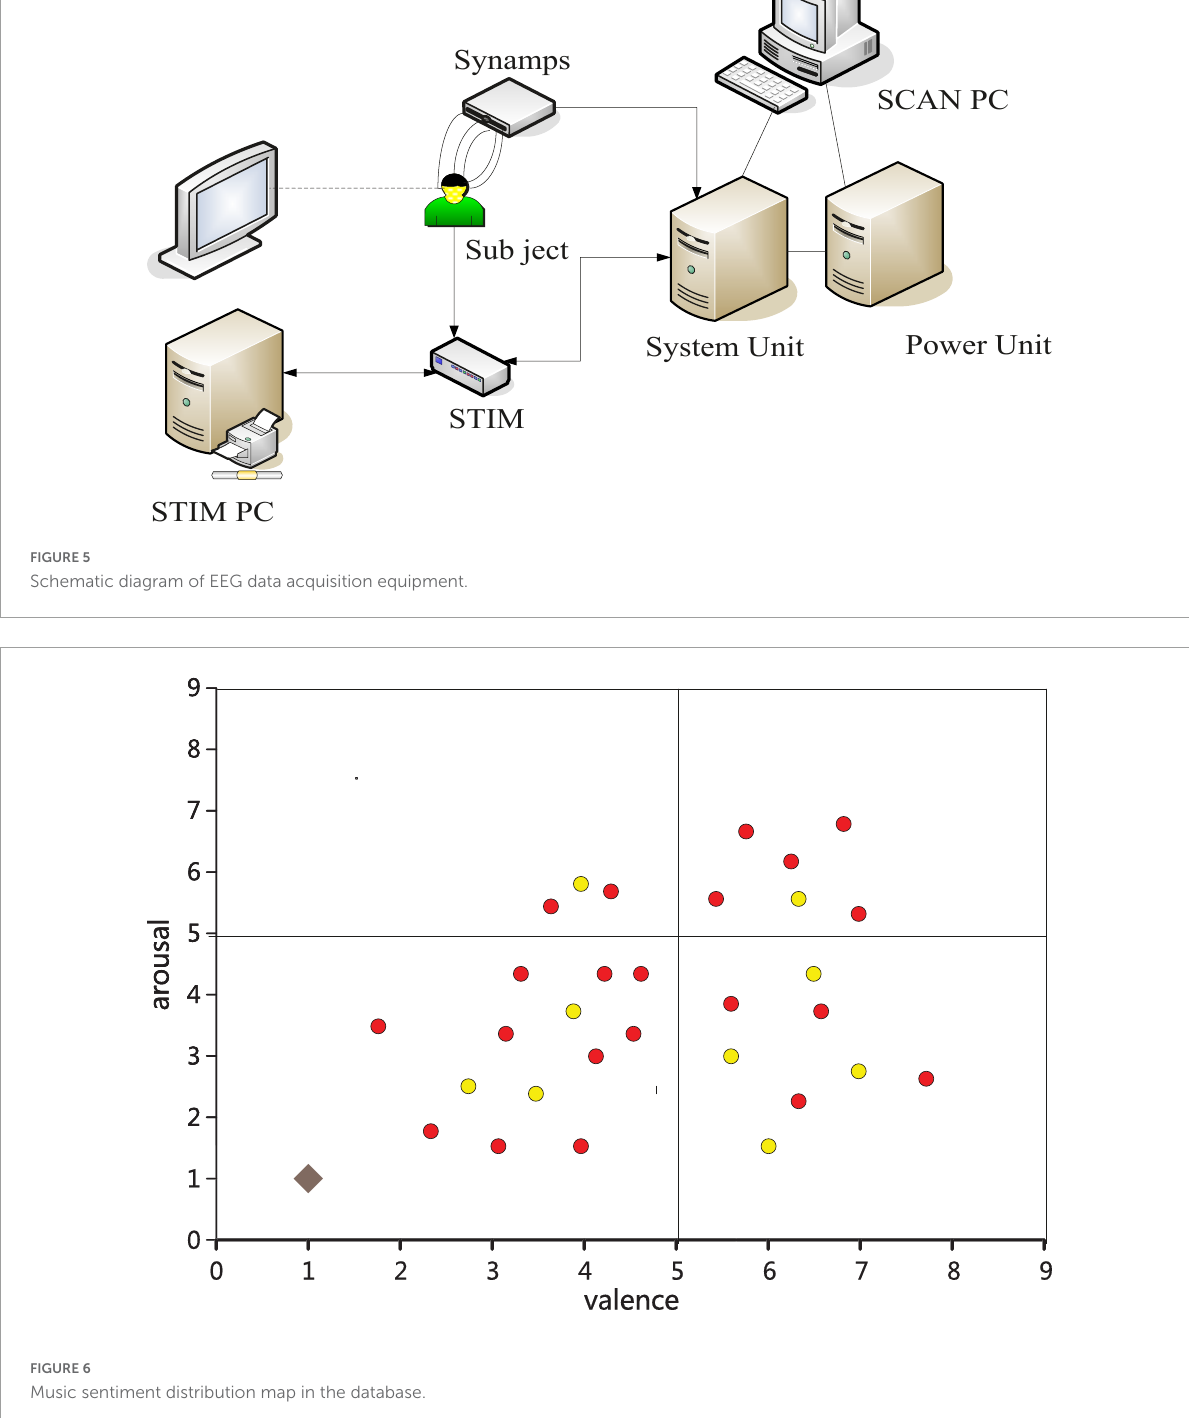
pleasure and low arousal (LVLA). Figure 7 is a brain network adjacency matrix for four different emotion types in the delta band during 0–500